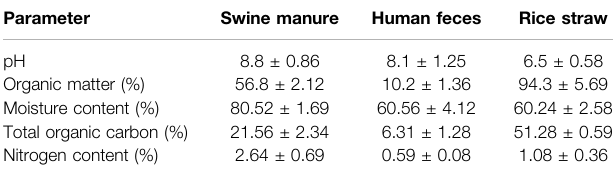
TABLE 1 | Physicochemical characteristics of the composting